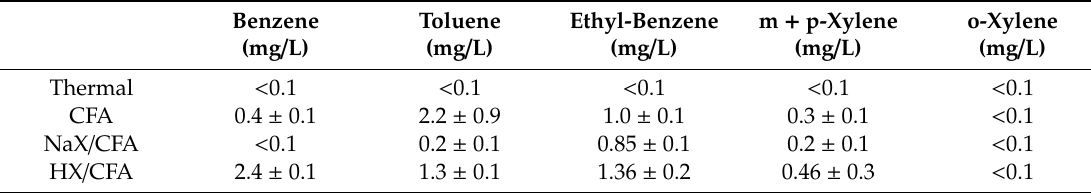
Table 3. Content of benzene, toluene, ethylbenzene, and xylenes, expressed as mg of hydrocarbon / L